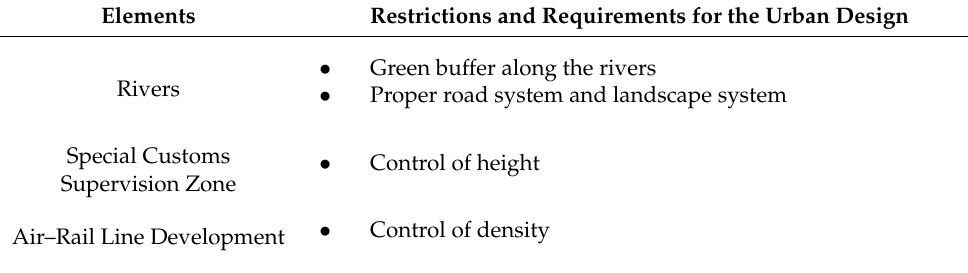
Table 2. Restrictions and requirements in air–rail line project.